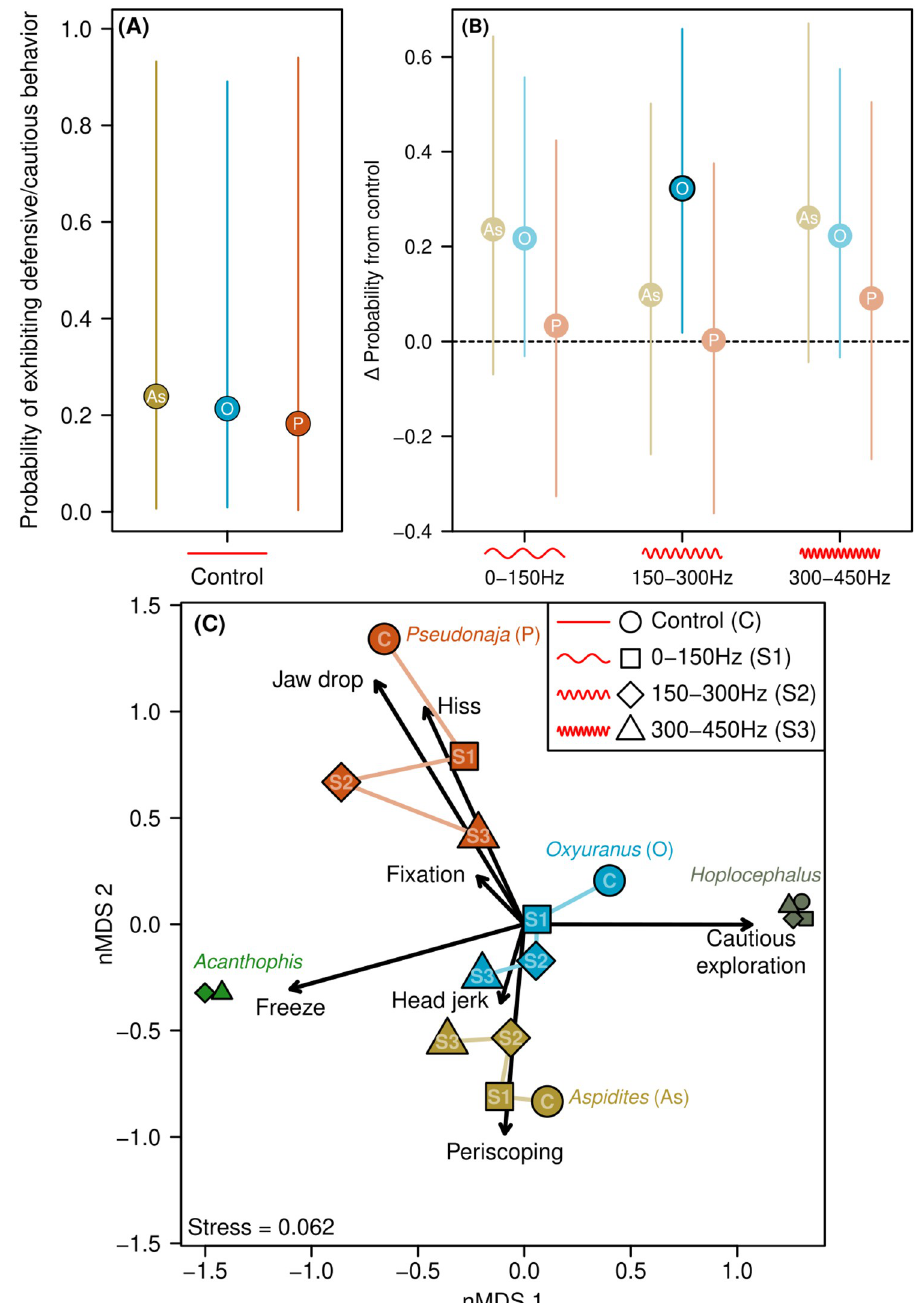
Fig 3. Defensive/cautious behavior responses of 19 snakes to sound compared to controls. (A) Mean probability of exhibiting defensive or cautious behavior in control trials for three snake genera with sufficient response (Fig 2). Behaviors included cautious exploration, fixation, freezing, hisses, head jerks, jaw drops and periscoping from n = 4 trials per snake. Lines represent 95% credible intervals. (B) Change in probability of exhibiting defensive or cautious behaviors from the control to each of three sound treatments. Values above zero indicate increase in probability, and vice versa. Faded points had credible intervals crossing zero, suggesting no change in probability from control (n = 4 per snake). (C) Non-metric multidimensional scaling of defensive/cautious behavior composition for each genus- sound treatment combination. Points with similar behavior composition are clustered on the plot, and are sized based on the total count of behaviors. Points in the same direction as arrows exhibited more of those behaviors, with arrow length proportional to strength of influence. Differences between control (“C”) and treatment points (“S1”, “S2” and “S3”) suggest the type of exhibited defensive behaviors changed in response to sound treatments. Symbols for the control and S1 are omitted for Acanthophis due to no behaviors being exhibited in those trials. Numbers are omitted from Acanthophis and Hoplocephalus symbols due to space